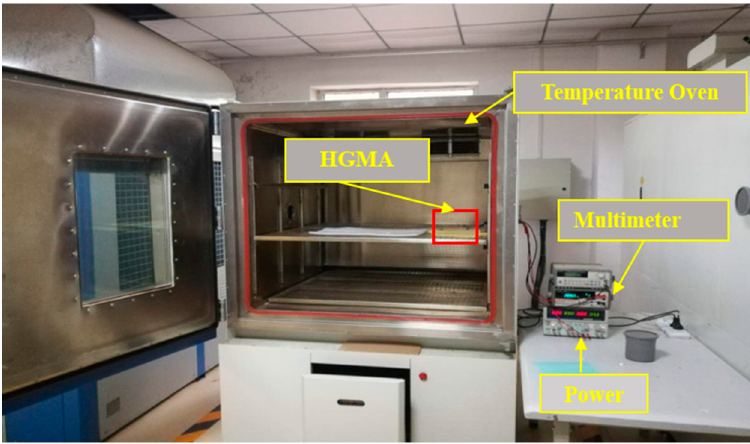
Figure 9. Temperature test equipment.